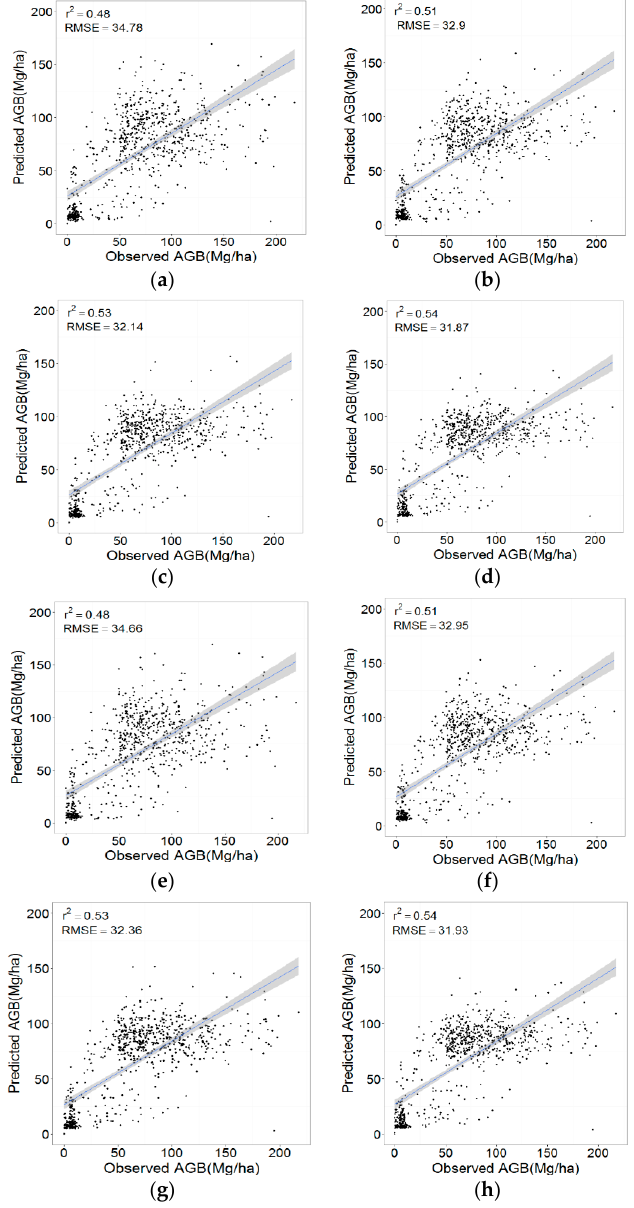
Figure A1. Predicted vs. observed (that is, referenced) AGB of sample plots using g-kNN with k value: ( a ) 3; ( b ) 5; ( c ) 7; and ( d ) 10; and CW-kNN with k value: ( e ) 3; ( f ) 5; ( g ) 7; and ( h ) 10.